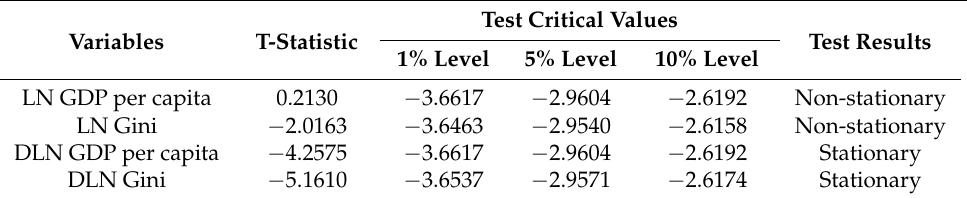
Table 4. Results of panel unit root test for